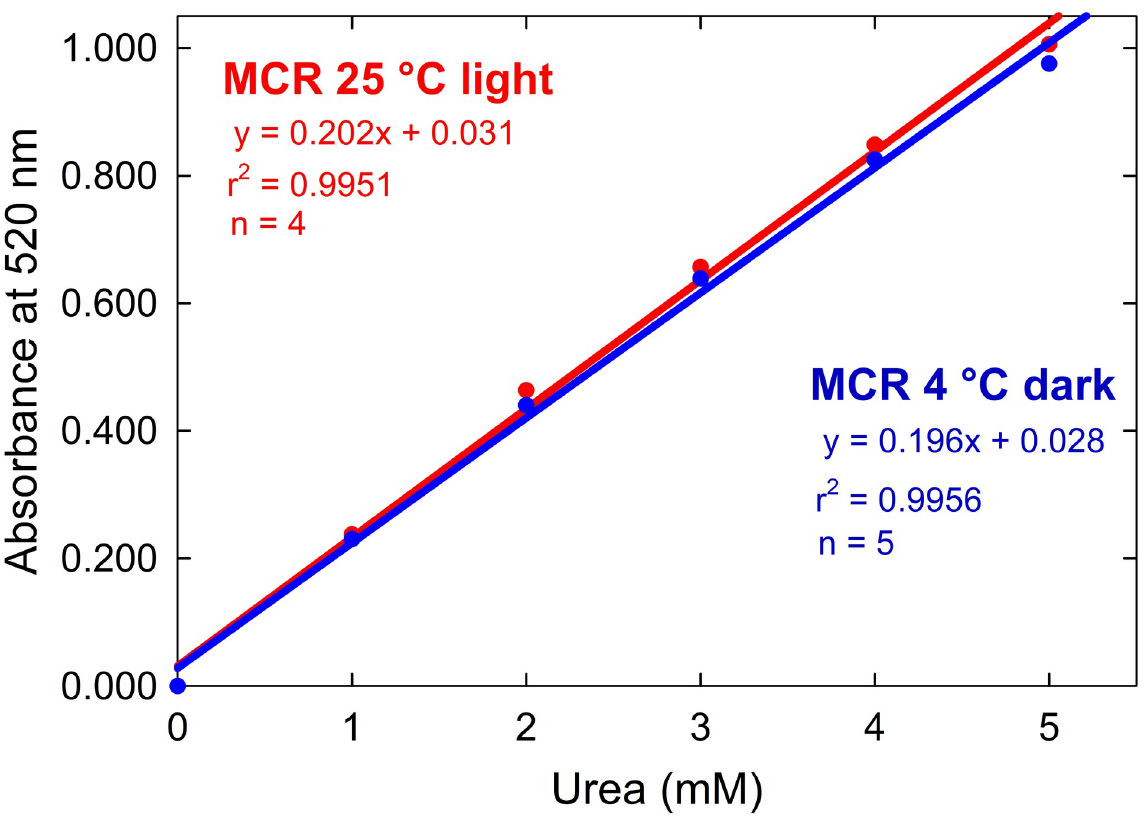
Fig 2. Calibration curve for urea. Calibration curves at 520 nm using a mixed color reagent (diacetyl monoxime and thiosemicarbazide, MCR) stored at 25 ˚C in the light and 4 ˚C in the dark. Error bars are too small to be shown (data included in S2 File). n = 4 for the 25 ˚C MCR and n = 5 for the 4 ˚C